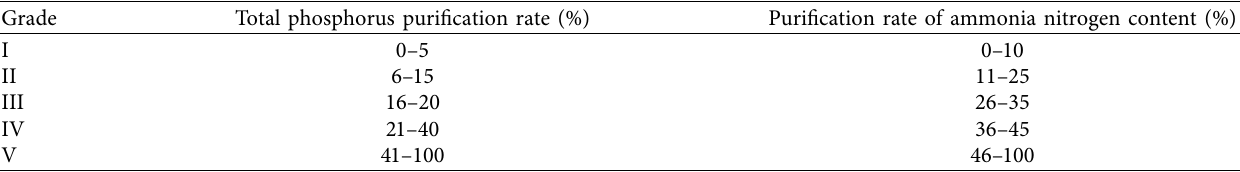
Table 1: Water quality index classification standard.